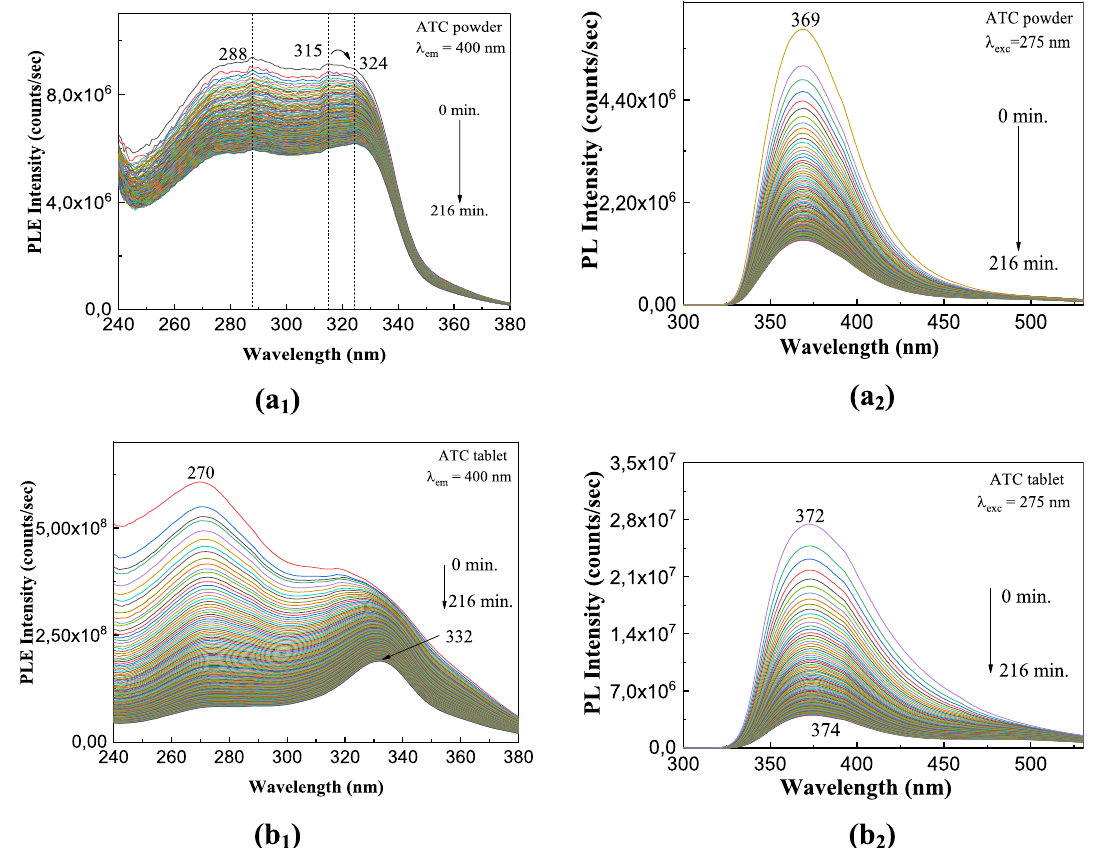
Figure 1. PLE (1) and PL (2) spectra of ATC in powder state ( a 1 , a 2 ) and as tablet ( b 1 , b 2 ) before and after exposure to UV light for 216